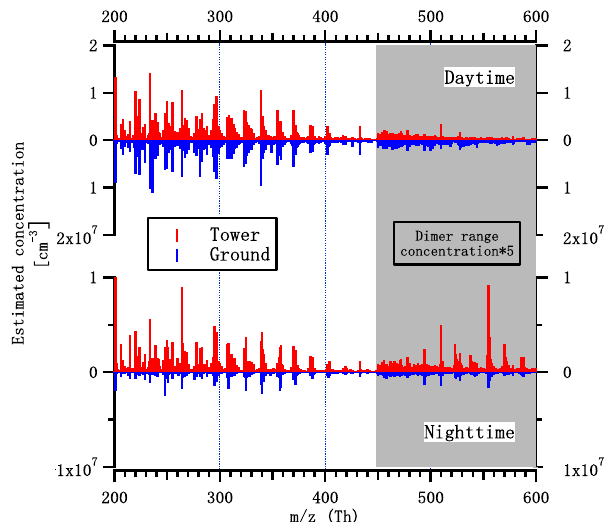
Figure 4. Mean mass spectra with the averaging periods of daytime (09:00–15:00) and nighttime (21:00–03:00) at the ground and tower